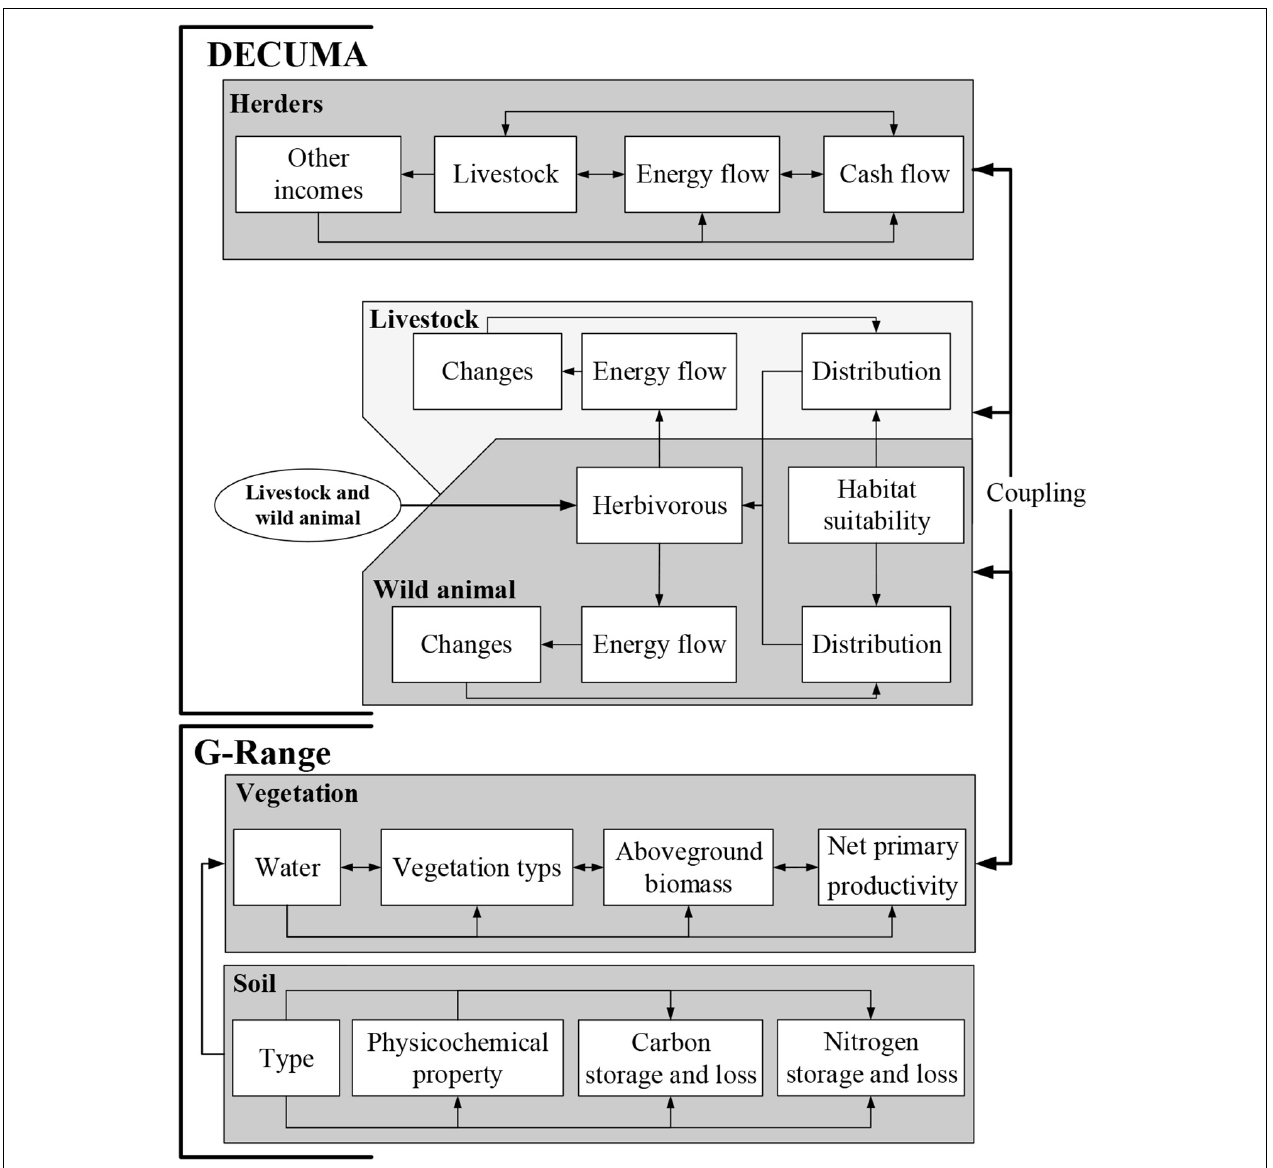
FIGURE 2 | Detailed information flows linking G-Range model and DECUMA